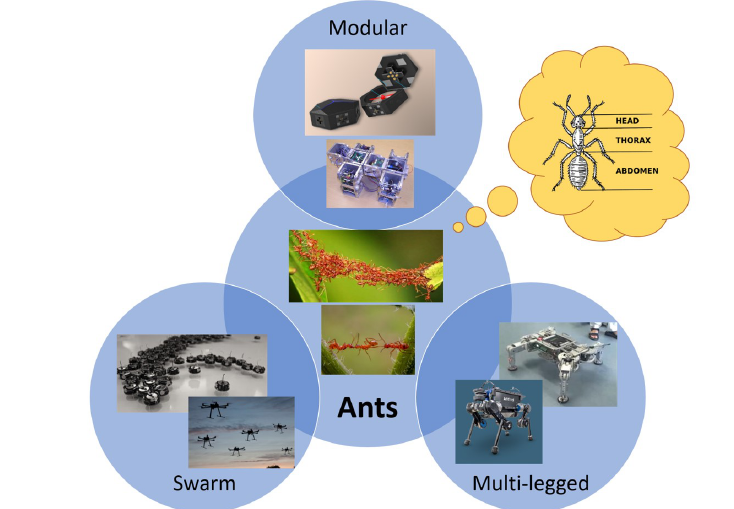
Figure 1. The design concept for the proposed ant-like robot is inspired by a variety of robot